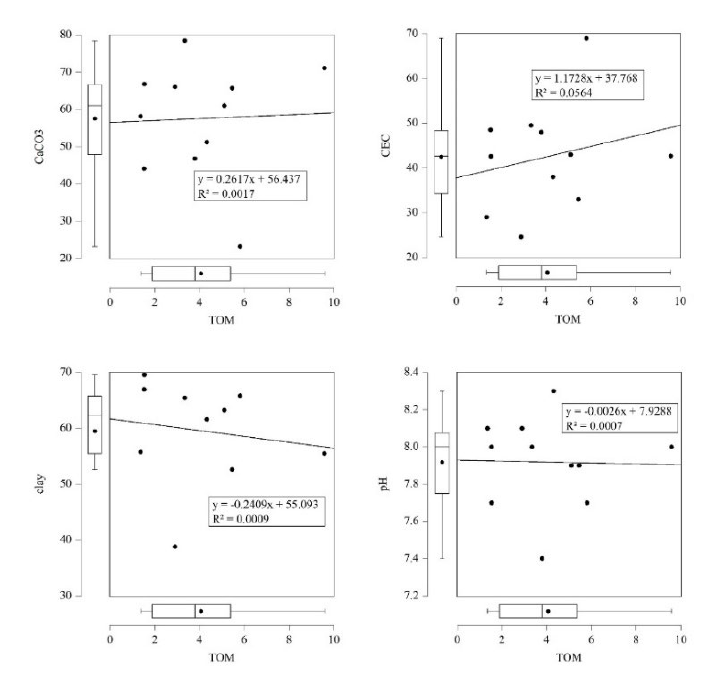
Figure 4. Scatter plot between some soil characteristics and TOM in rangeland